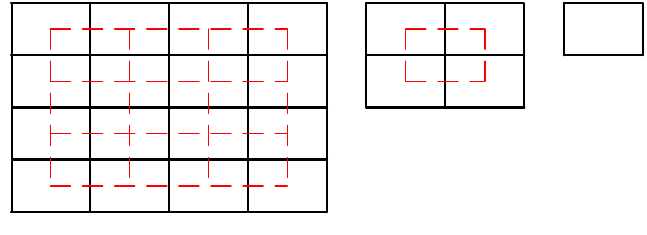
Figure 2. Spatial pyramid for CENTRIST.